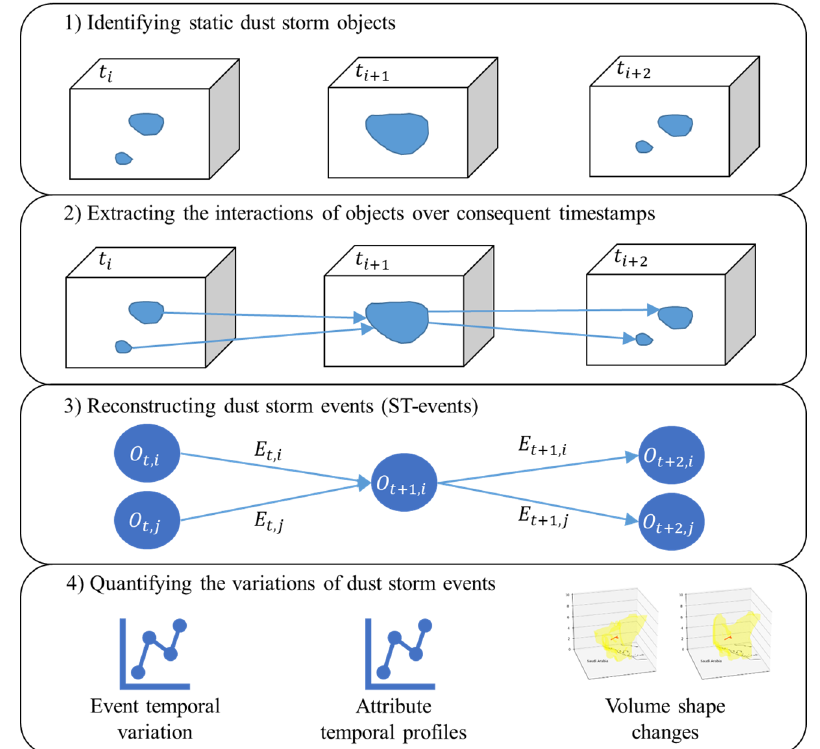
Figure 4. Overall procedure of dust event representation and quantification.